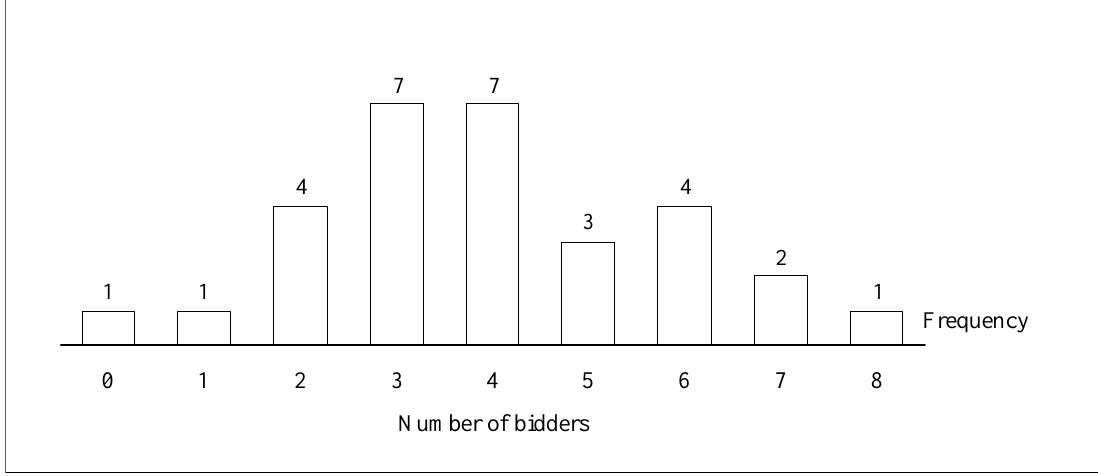
Figure 4. Frequency distribution of number of